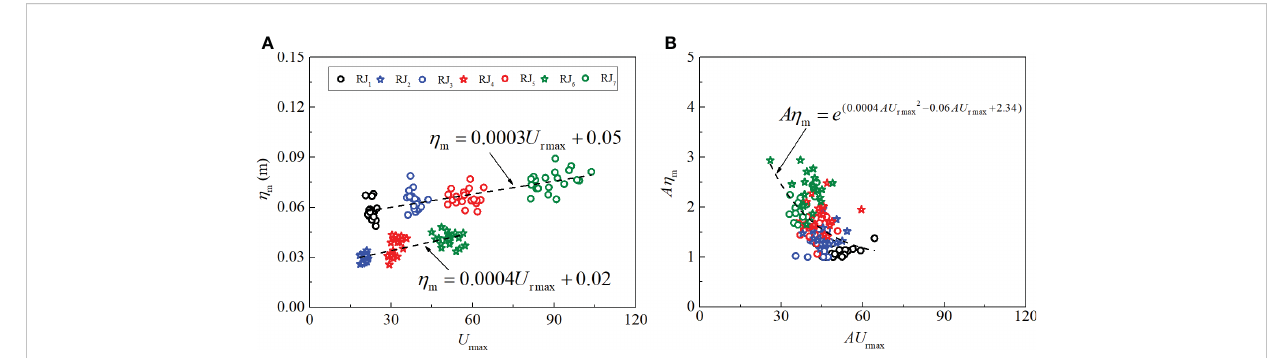
FIGURE 3 Scatters for the relationship between the maximum Ursell number, U rmax , and the maximum crest height, h m (A) , and the dependence between the enlargement factors AU rmax and A h m for the U rmax and the h m (B)